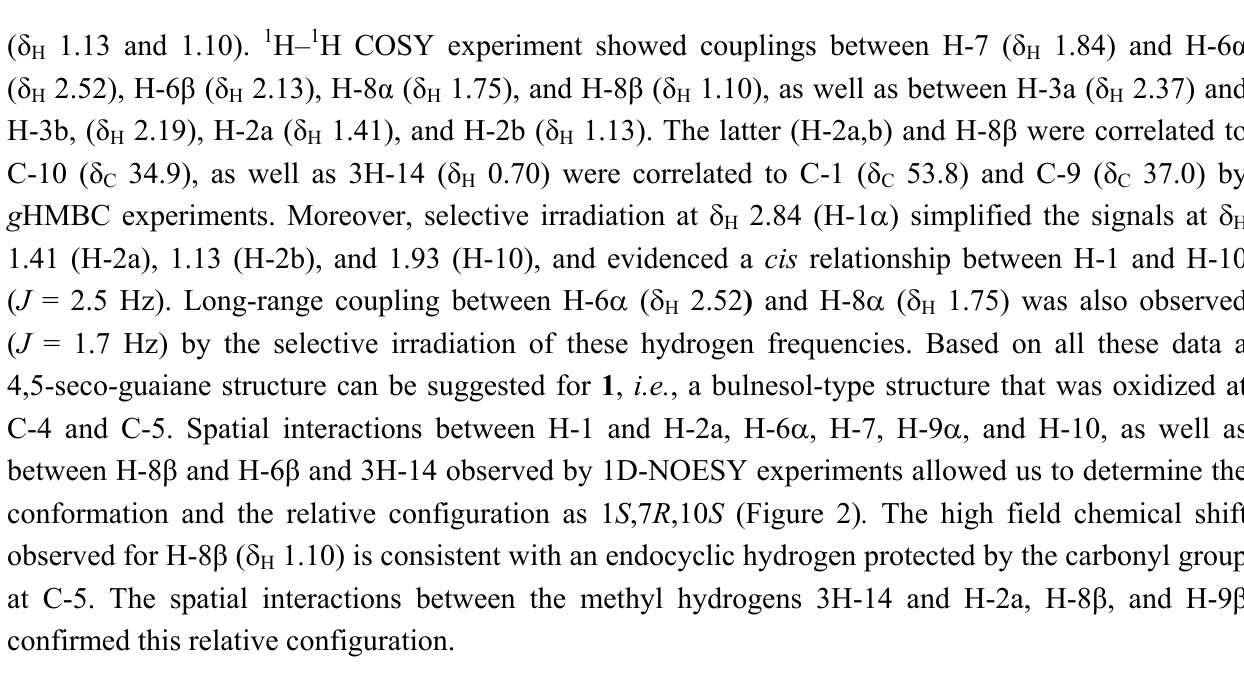
Table 1. NMR Spectroscopic Data for Compound 1 (CDCl